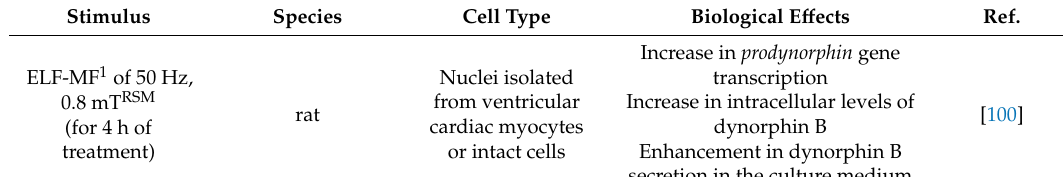
Table 3. Magnetic fields (MF) studies and cardiac